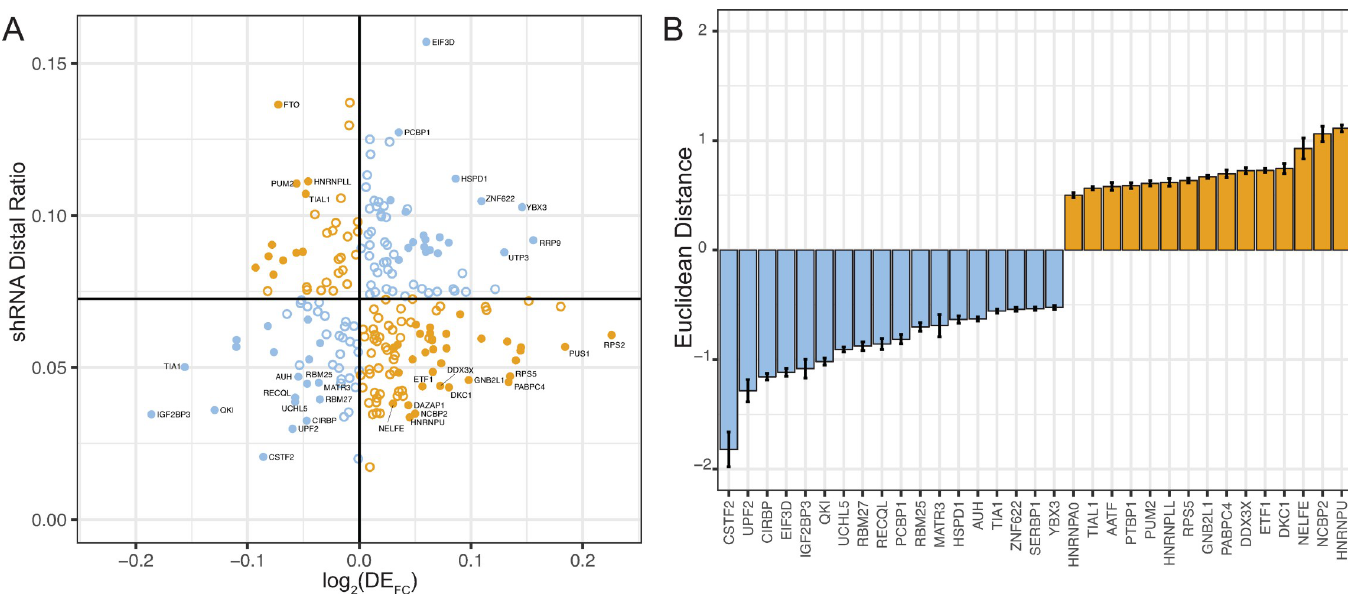
Fig 5. Role of RNA binding proteins and relative single-cell populations in modulating SERPINA1 APA. A) Two-dimensional volcano plot of endogenous shRNA distal ratio in SERPINA1 (y-axis) as a function of log 2 differential expression fold change (log 2 (DE FC )) in LTRC primary lung tissue from 376 COPD cases and 267 controls for the 224 corresponding RNA binding proteins. The horizontal line represents the mean distal ratio in the corresponding empty vector shRNA controls, while the vertical line is centered on zero. Blue points (bottom right quadrant and top left quadrant) will decrease the distal ratio in COPD, while orange points (top left and bottom right quadrant) will increase the distal ratio. Filled circles indicate RNA binding proteins for which the distal ratio changes from shRNA control, and log 2 (DE FC ) are both significant in both data sets with p adj < 0.05. B.) log 2 computed Euclidean distance from center of two-dimensional volcano plot for significant (p adj < 0.05) RNA binding proteins affecting COPD. Again, those RNA binding proteins expected to lower the distal ratio are colored blue and negative, while those expected to increase the distal ratio are orange and positive.